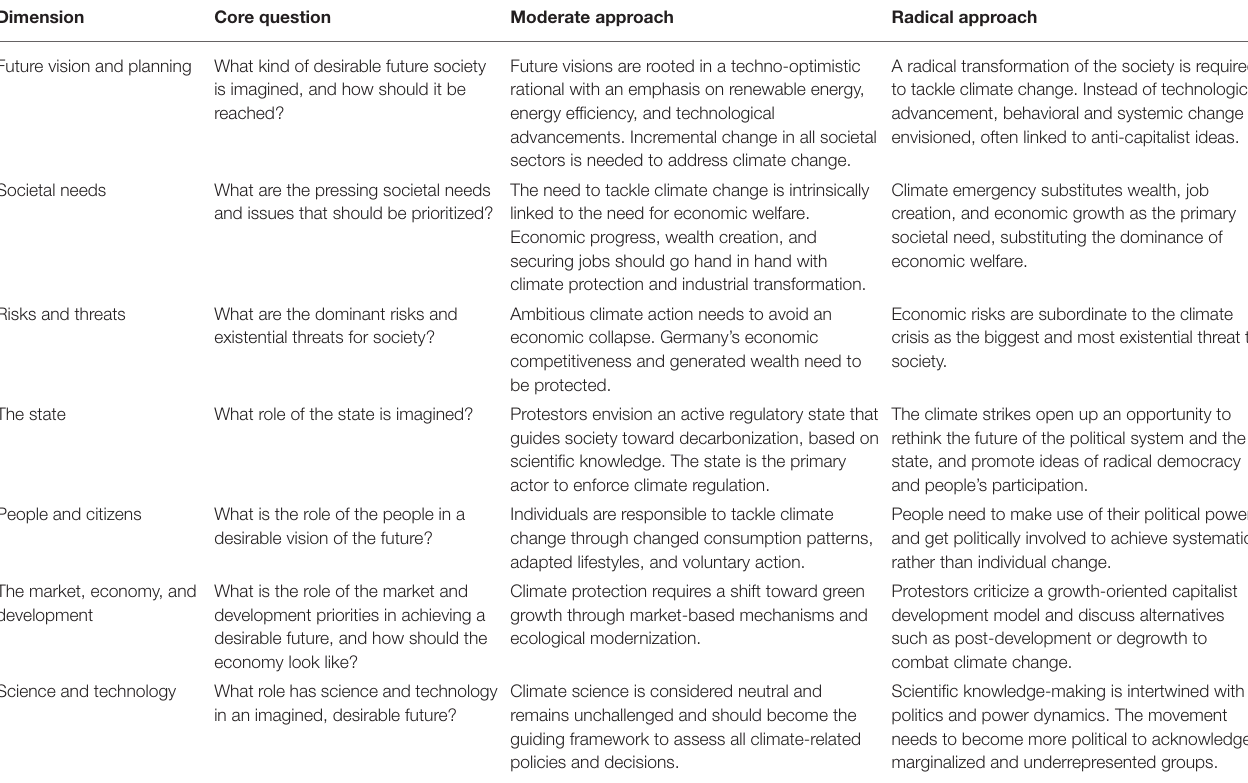
TABLE 2 | Two competing emerging imaginaries: moderate vs. a radical approach.